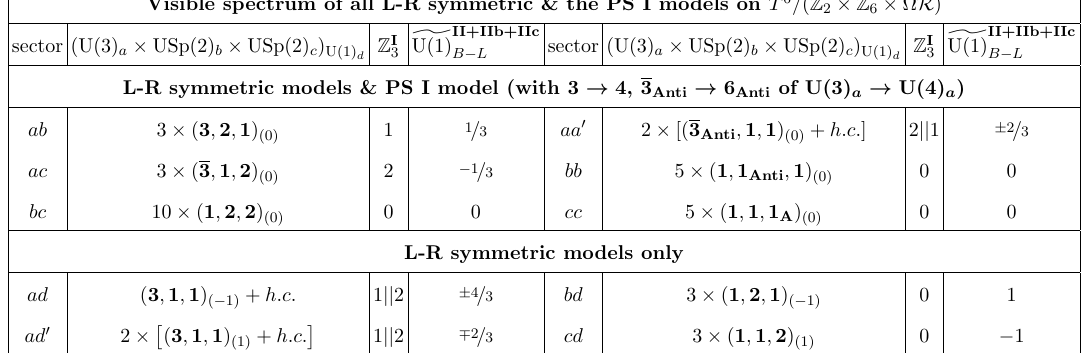
Table 19 . Common visible spectrum of the L-R symmetric models. Prototype I has the low- energy gauge group SU(3) a (cid:2) USp(2) b (cid:2) USp(2) c (cid:2) SU(3) h (cid:2) SU(3) h (cid:2) Z 3 with the Z 3 charge 1 2 displayed in the third and seventh column. The prototype II model has the low-energy gauge group ] ] SU(3) a (cid:2) USp(2) b (cid:2) USp(2) c (cid:2) U(1) with the U(1) (cid:17) 1 U(1) a (cid:0) U(1) d (cid:0) U(1) h + U(1) h B (cid:0) L B (cid:0) L 3 1 2 ] charge displayed in the fourth and eighth column. For the prototype IIb & IIc models, the U(1) B (cid:0) L symmetry is massive and thus only a perturbative global symmetry. The massless matter spectrum is completed by the ‘hidden’ sectors displayed in table 20 for each prototype I, II, IIb and IIc. The massless closed string sector is for each case identical to the MSSM-like model, i.e. it contains ( h 11 ; h 11 ; h 21 ) = (4 ; 15 ; 19) vectors, K(cid:127)ahler moduli and complex structure moduli, respectively. + (cid:0) pensated by vev s of scalars in the h h ( 0 ) sectors, which would simultaneously 1 2